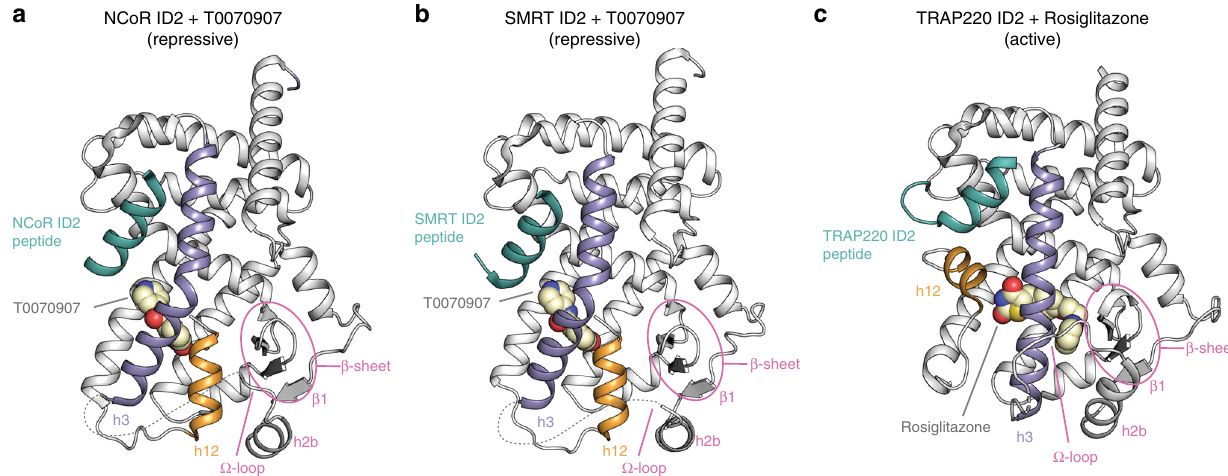
Fig. 2 Structure of PPAR γ LBD bound to T0070907 and corepressor peptides. a Crystal structure of PPAR γ LBD bound to the corepressor-selective inverse agonist T0070907 and NCoR ID2 peptide (PDB 6ONI). b Crystal structure of PPAR γ LBD bound to the corepressor-selective inverse agonist T0070907 and SMRT ID2 peptide (PDB 6PDZ). c Crystal structure of PPAR γ LBD bound to the coactivator-selective agonist rosiglitazone and TRAP220 ID2 peptide (PDB